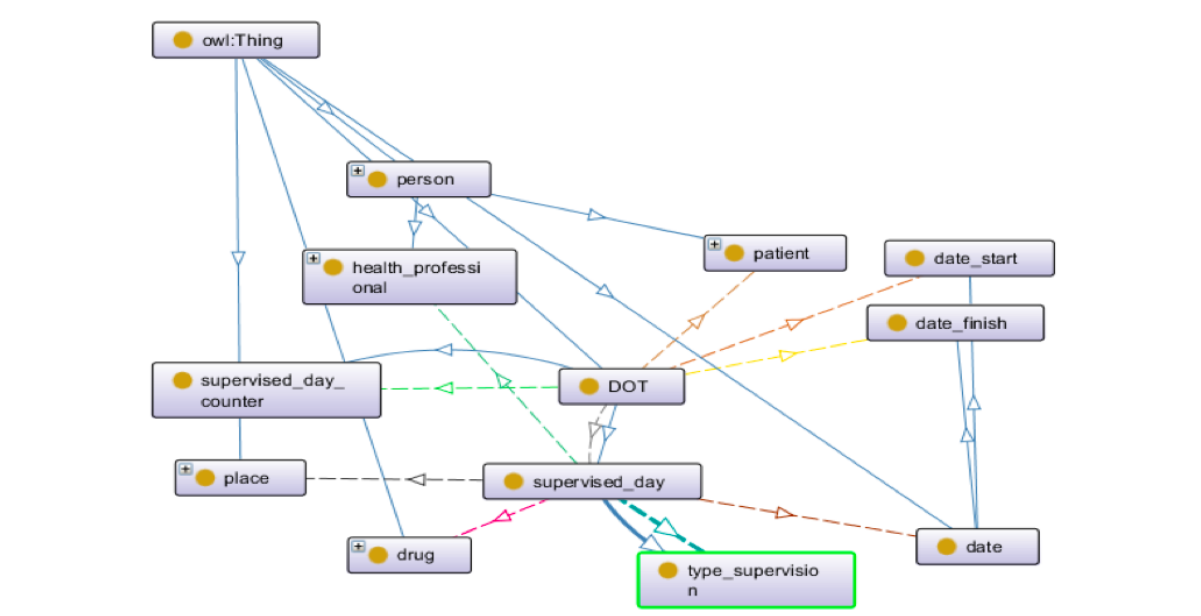
Figure 1. The ontology for directly observed treatment, short-course (DOTS) to support interoperability in the Brazilian public health